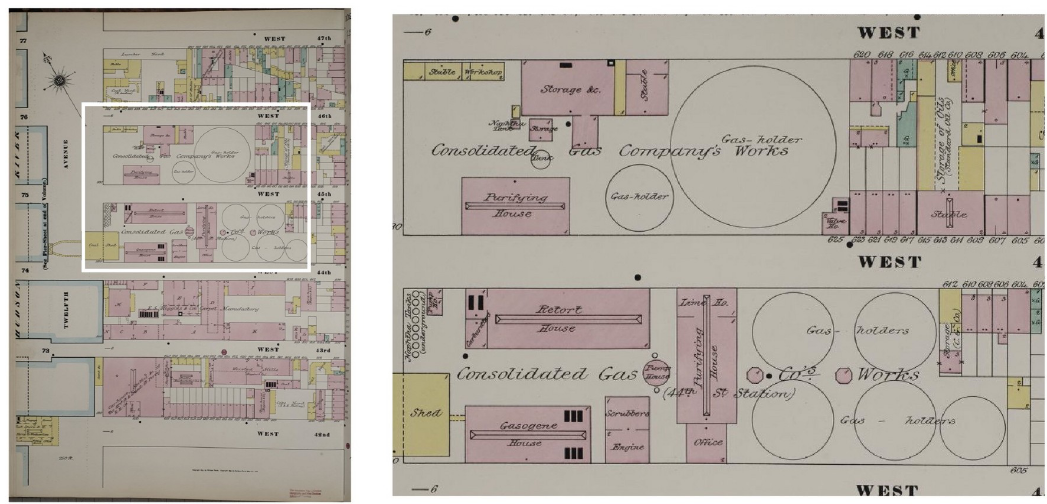
Fig 1. Circular gasometer structures as they appear in Sanborn fire insurance maps. Fig source: Sanborn Map Company.